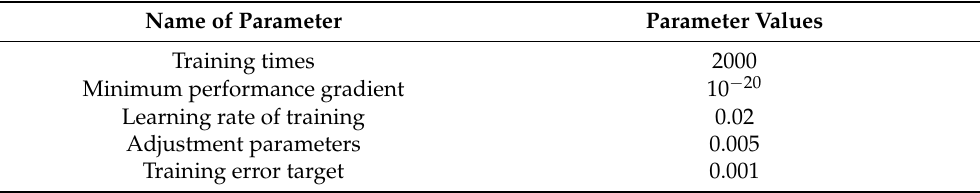
Table 4. The parameters of the